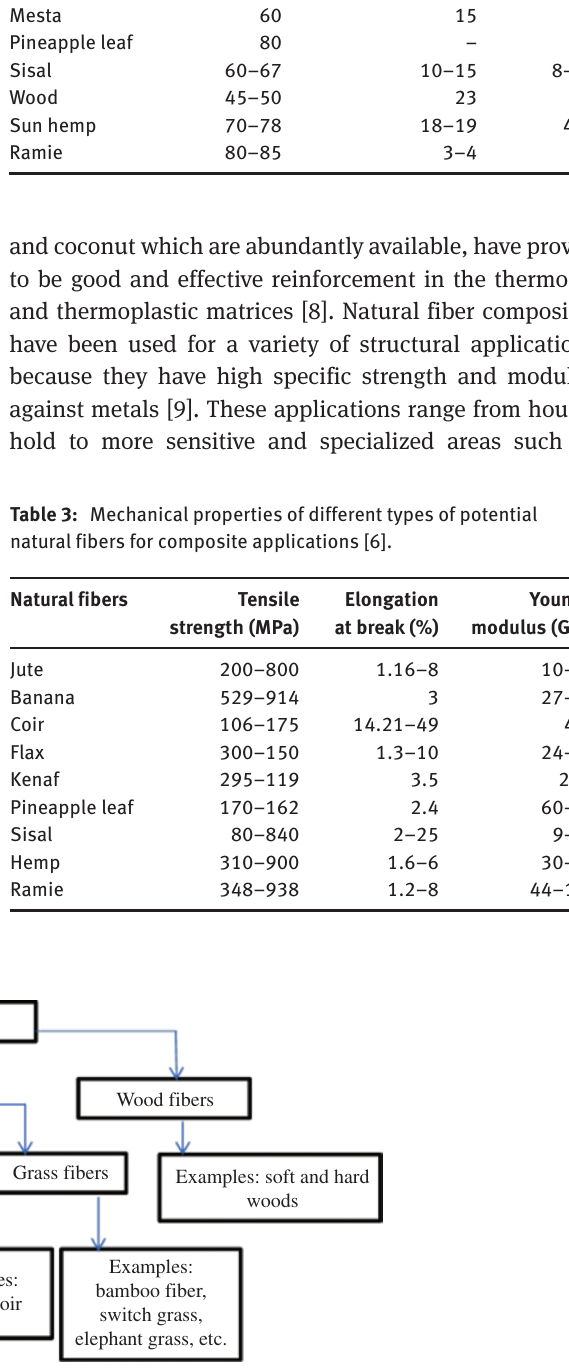
Figure 1: Classification of natural fibers [3].